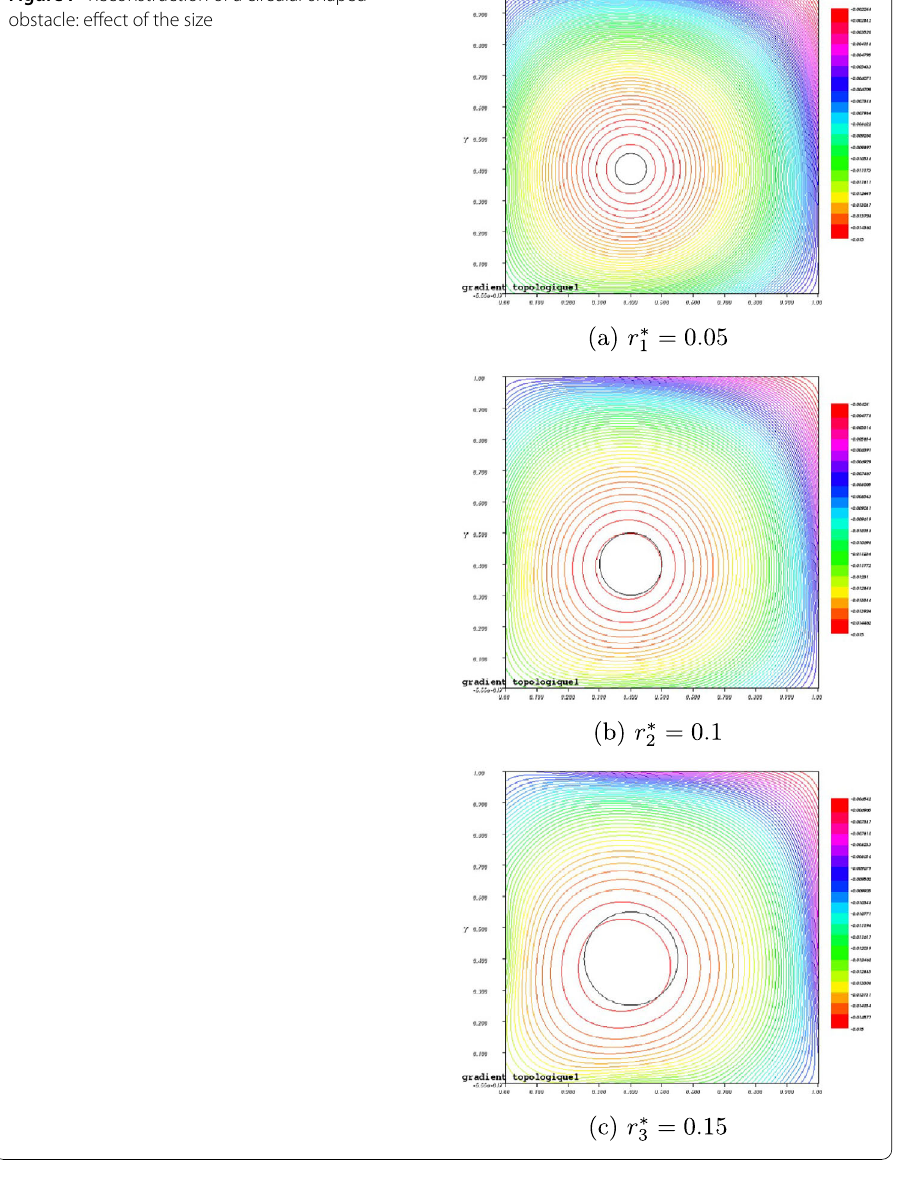
Figure 7 Reconstruction of a circular shaped obstacle: effect of the